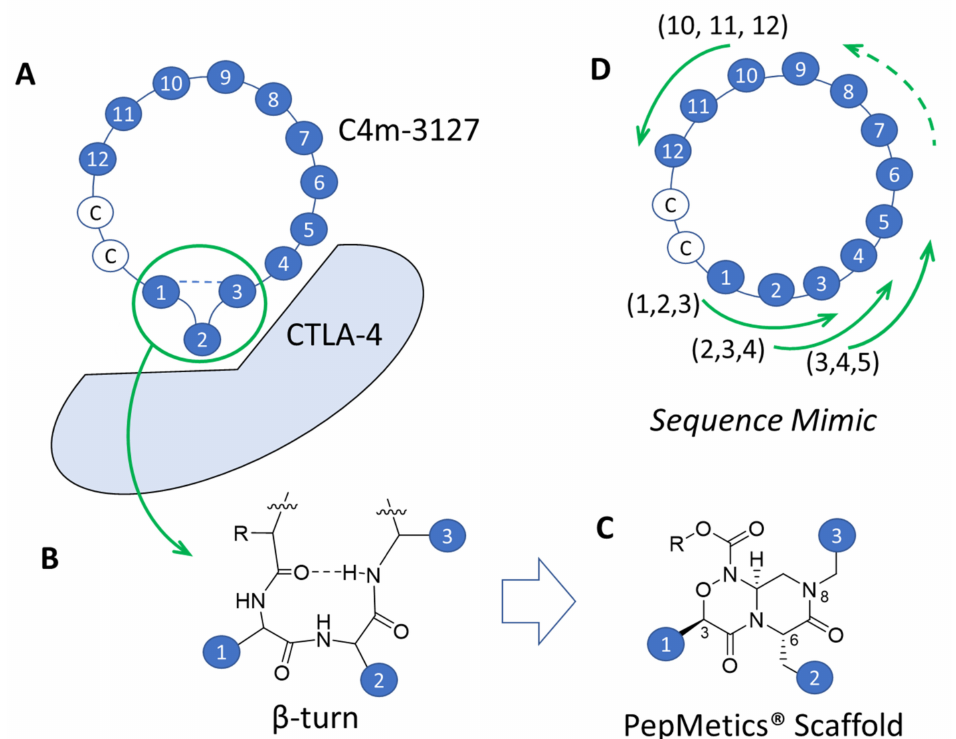
Figure 6. Sequence mimic: Strategy of transforming cyclic peptides to small molecules. ( A ) Con- ceptual diagram of interaction between C4m-3127 and CTLA-4. Dashed lines indicate hydrogen bonds. C, cysteine. Numbers from 1 to 12 correspond to sequence 1 MHPFLPIVSHHF 12 . ( B ) Chemical structure of β -turn. Dashed lines indicate hydrogen bonds. ( C ) Representative PepMetics ® scaffold used in this research, among more than 40 kinds of scaffolds. For synthetic reasons, PepMetics ® scaffold cannot mimic histidine at the 3-position and proline at 6- and 8-positions. ( D ) Conceptual diagram of sequence mimic, with 10 patterns for mimicking sequences from (1, 2, 3) to (10, 11, 12). Because of the limitation of PepMetics ® for proline mimicking, this scaffold did not mimic the four sequences (M1, H2, P3), (H2, P3, F4), (F4, L5, P6), and (L5, P6,